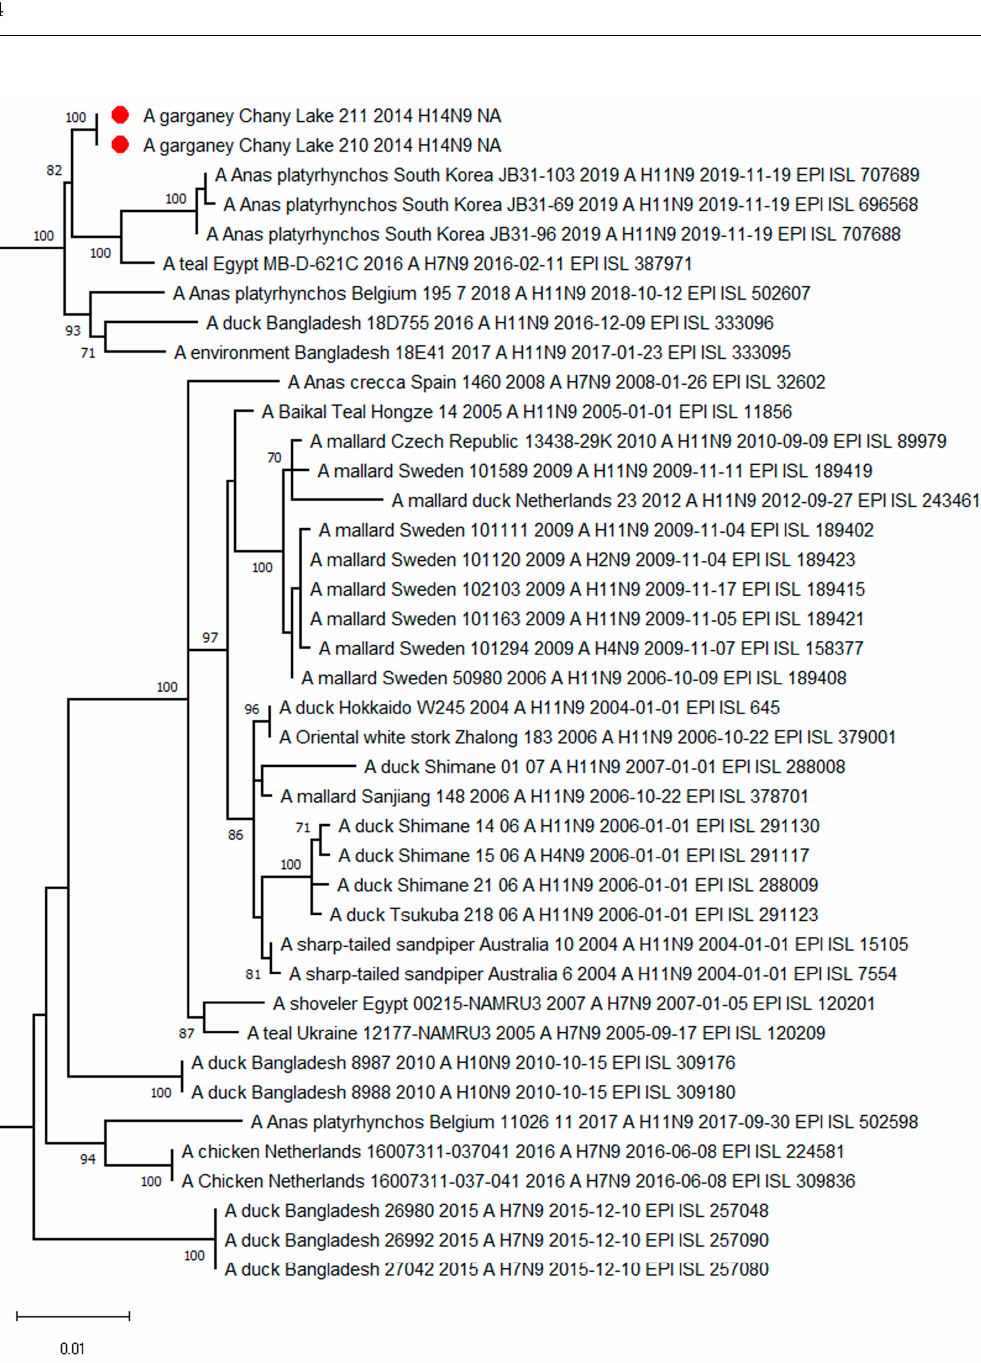
Figure 4. Maximum likelihood phylogenetic tree of the NA-subtype N9 genome segment of avian influenza viruses ( ● —sequences from this study).